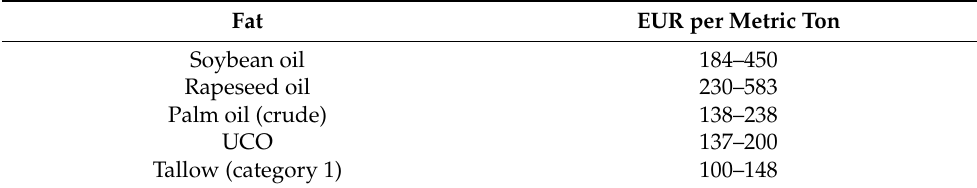
Figure 1. Biodiesel production from animal fat flowsheet (adapted from [19]). Table 1. Fats raw materials prices (www.alibaba.com, accessed on 1 March